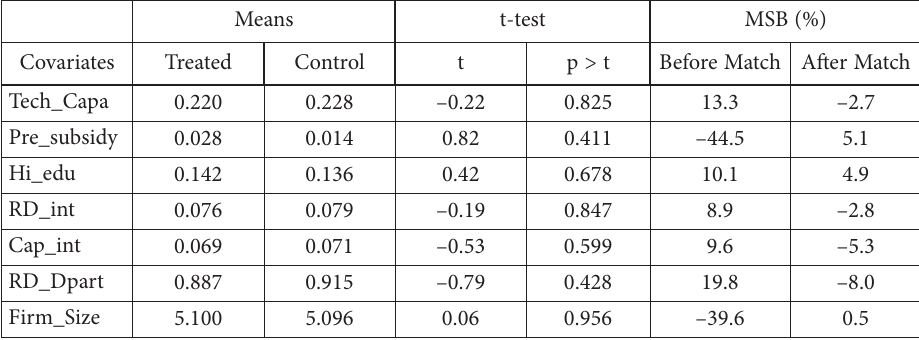
Table A.4. Balance test for the First-Step